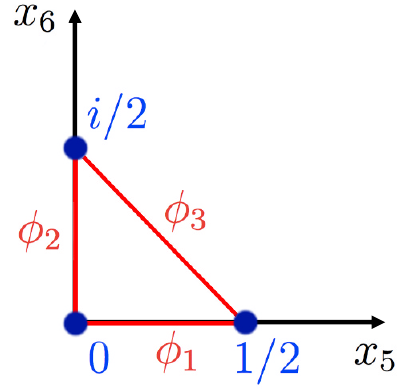
Figure 1 . The 5d branes where each (cid:13)avon propagate. The e(cid:11)ective extra dimensional space is the space inside the red triangle. The Flavons propagate through the